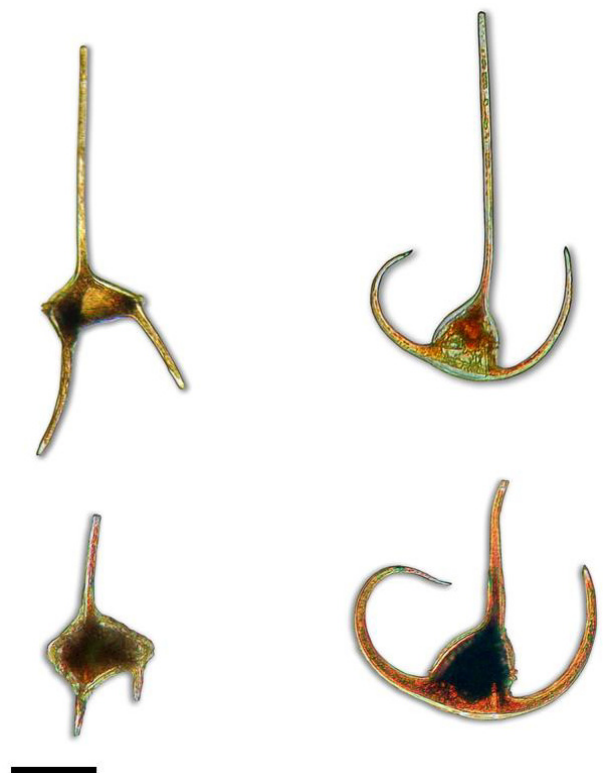
Figure 1. Illustration of infraspecific morphological variations in Neoceratium species. Slender variety depressum (upper left) and robust variety candelabrum (bottom left) in N. candelabrum . Slender variety gracilentum (upper right) and robust variety arietinum (bottom left) in N. arietinum . Bar scale 50 μ m. Lugol-fixed